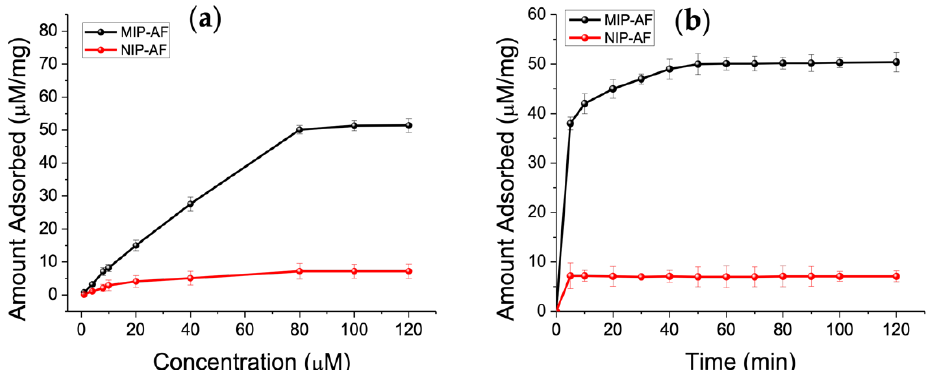
Figure 5. ( a ) Adsorption isotherms of Trp (1 – 120 µM) on MIP-AF (red) and NIP-AF(black). Amount of MIPs or NIPs: 1 mg mL1; volume: typically 1.0 mL; time: 1 h. The three measures ’ means are shown by the dots. ( b ) Adsorption kinetics of Trp on MIP-AF and NIP-AF.